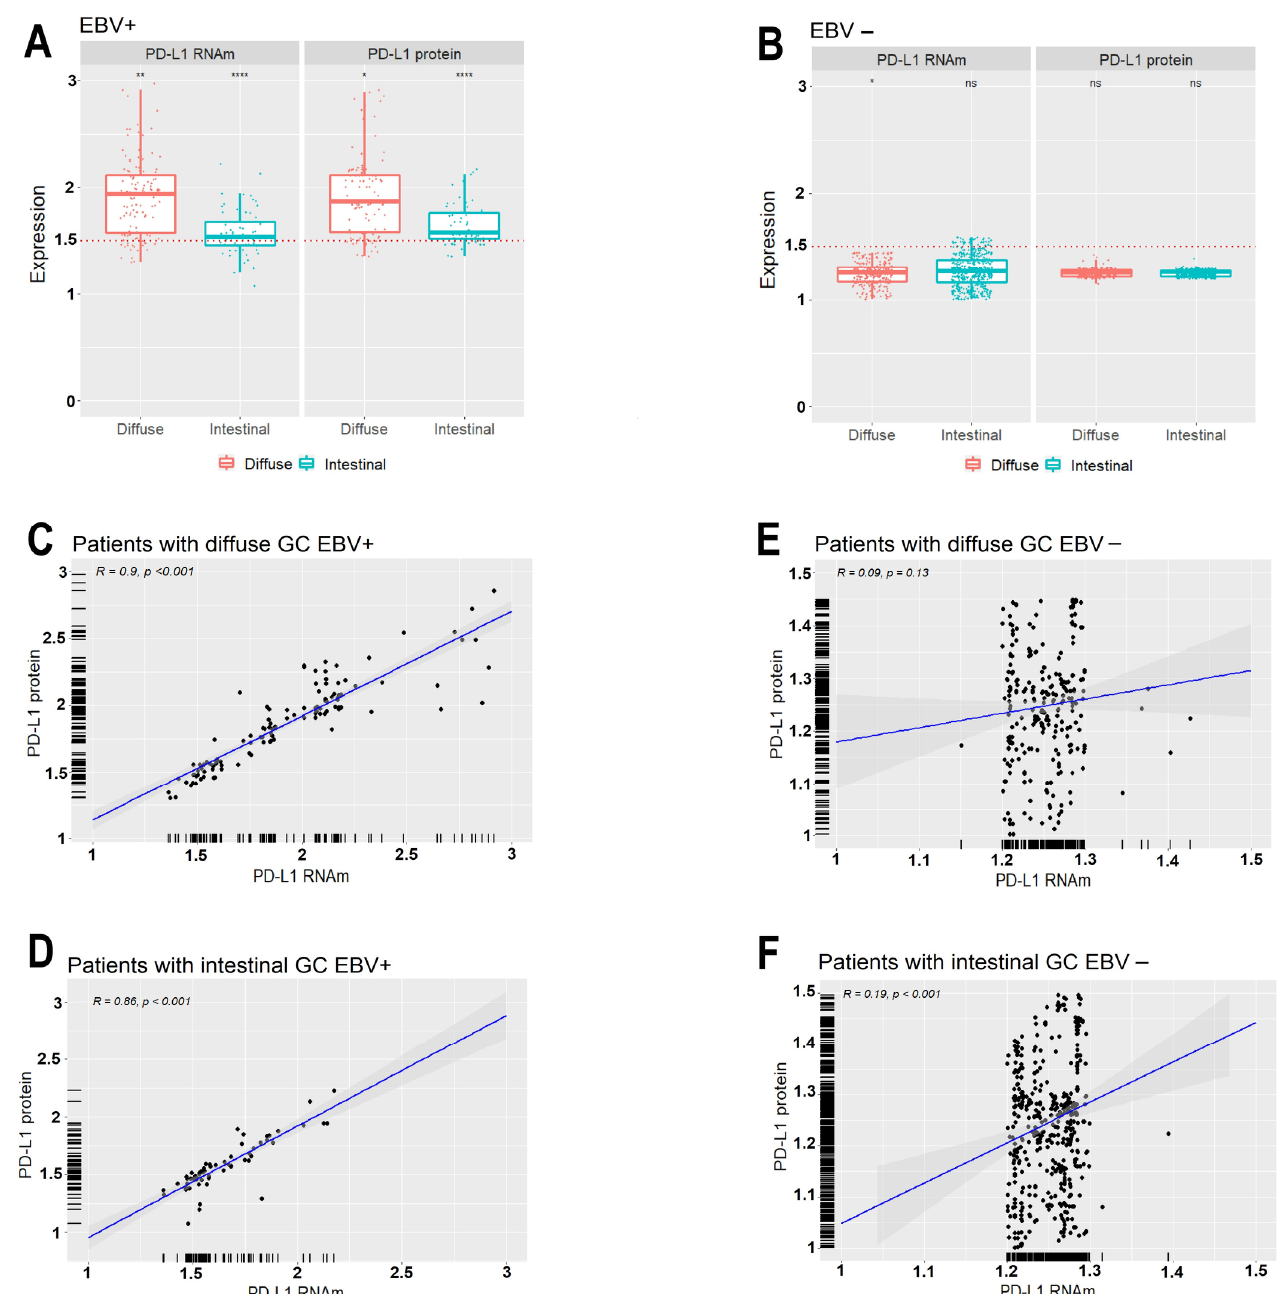
Figure 2. ( A , B ) Relative normalized expression of PD-L1 mRNA and protein in tumor gastric tissue of patients with diffuse and intestinal gastric cancer with positive and EBV-negative status presented in Box plots. The red dotted lines represent the 1.5-fold-change. (ns, not significant, * p < 0.05, ** p < 0.01, **** p < 0.0001). The horizontal lines inside the boxes represents the median of expression values. The vertical lines above and below the box delineate the maximum and minimum values, and the dots indicate outliers. ( C , D ) Linear correlation of increased PD-L1 mRNA and protein levels in EBV-positive patients with diffuse histology (R = 0.90, p < 0.01) and intestinal (R = 0.86, p < 0.01). ( E , F ) Linear correlation of increased PD-L1 mRNA and protein levels in EBV-negative patients with diffuse histological (R = 0.09, p = 0.13) and intestinal (R = 0.19, p <